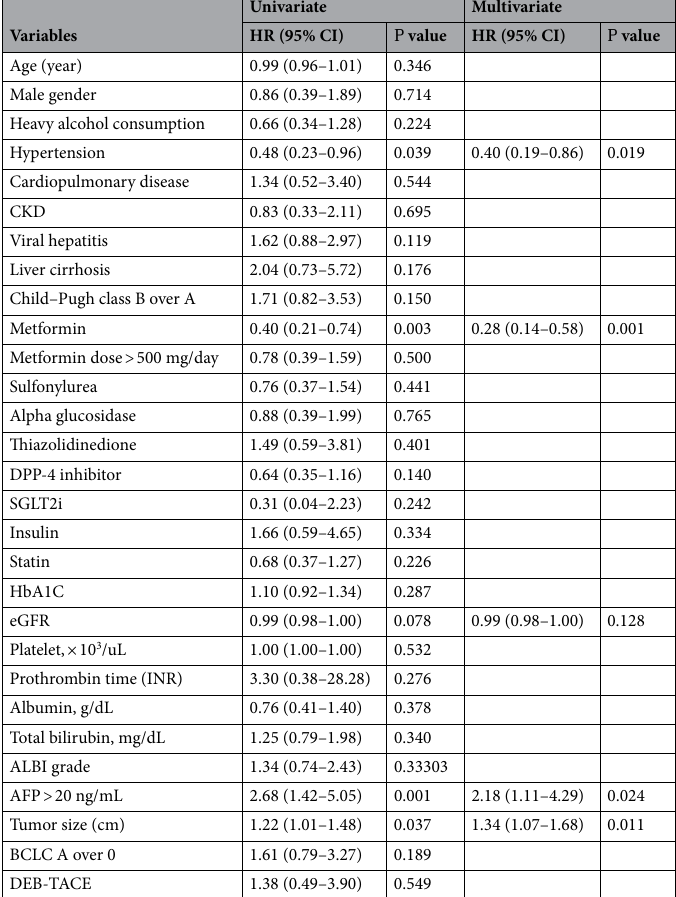
Table 3. Cox regression analysis for predictors of local HCC recurrence in all diabetic patients with complete response after TACE (N = 90). TACE transarterial chemoembolization, HCC hepatocellular carcinoma, HR hazard ratio, CI confidence interval, AFP alpha-fetoprotein, INR international normalized ratio, RFA radiofrequency